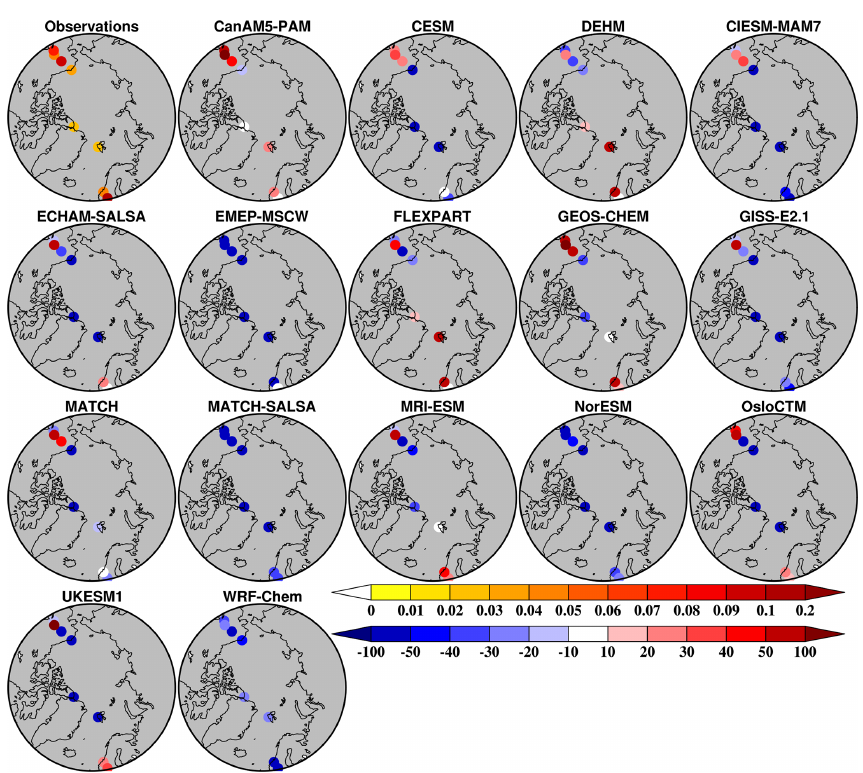
Figure 13. Mean BC concentrations (µgm − 3 , top color bar) at surface Arctic measurement sites and model bias (as (model– measurement) / measurement in percent, bottom color bar) for 2014–2015. Results from 2008–2009 are similar and not shown.